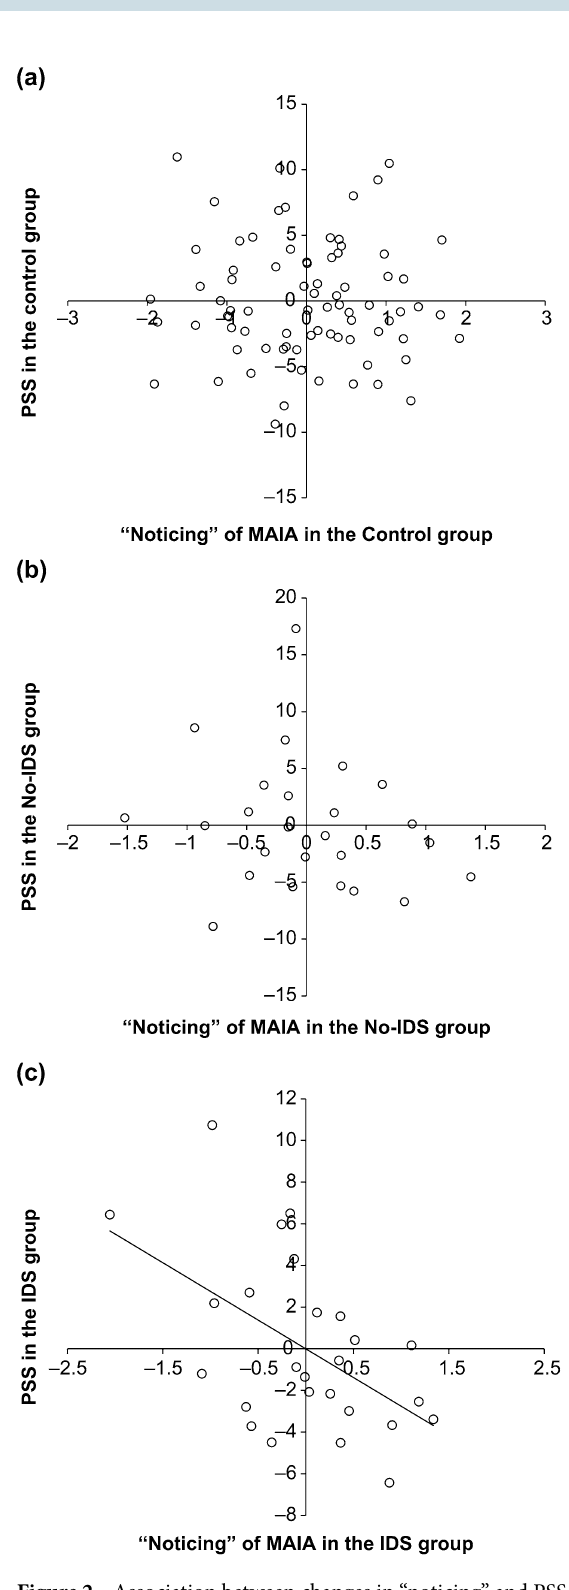
Figure 2. Association between changes in “noticing” and PSS for each group. ( a ) Control group ( n = 78), ( b ) IDS group ( N = 25), and ( c ) No-IDS group ( N = 26). The control variables were “noticing” and PSS in Session 1. The line is the regression